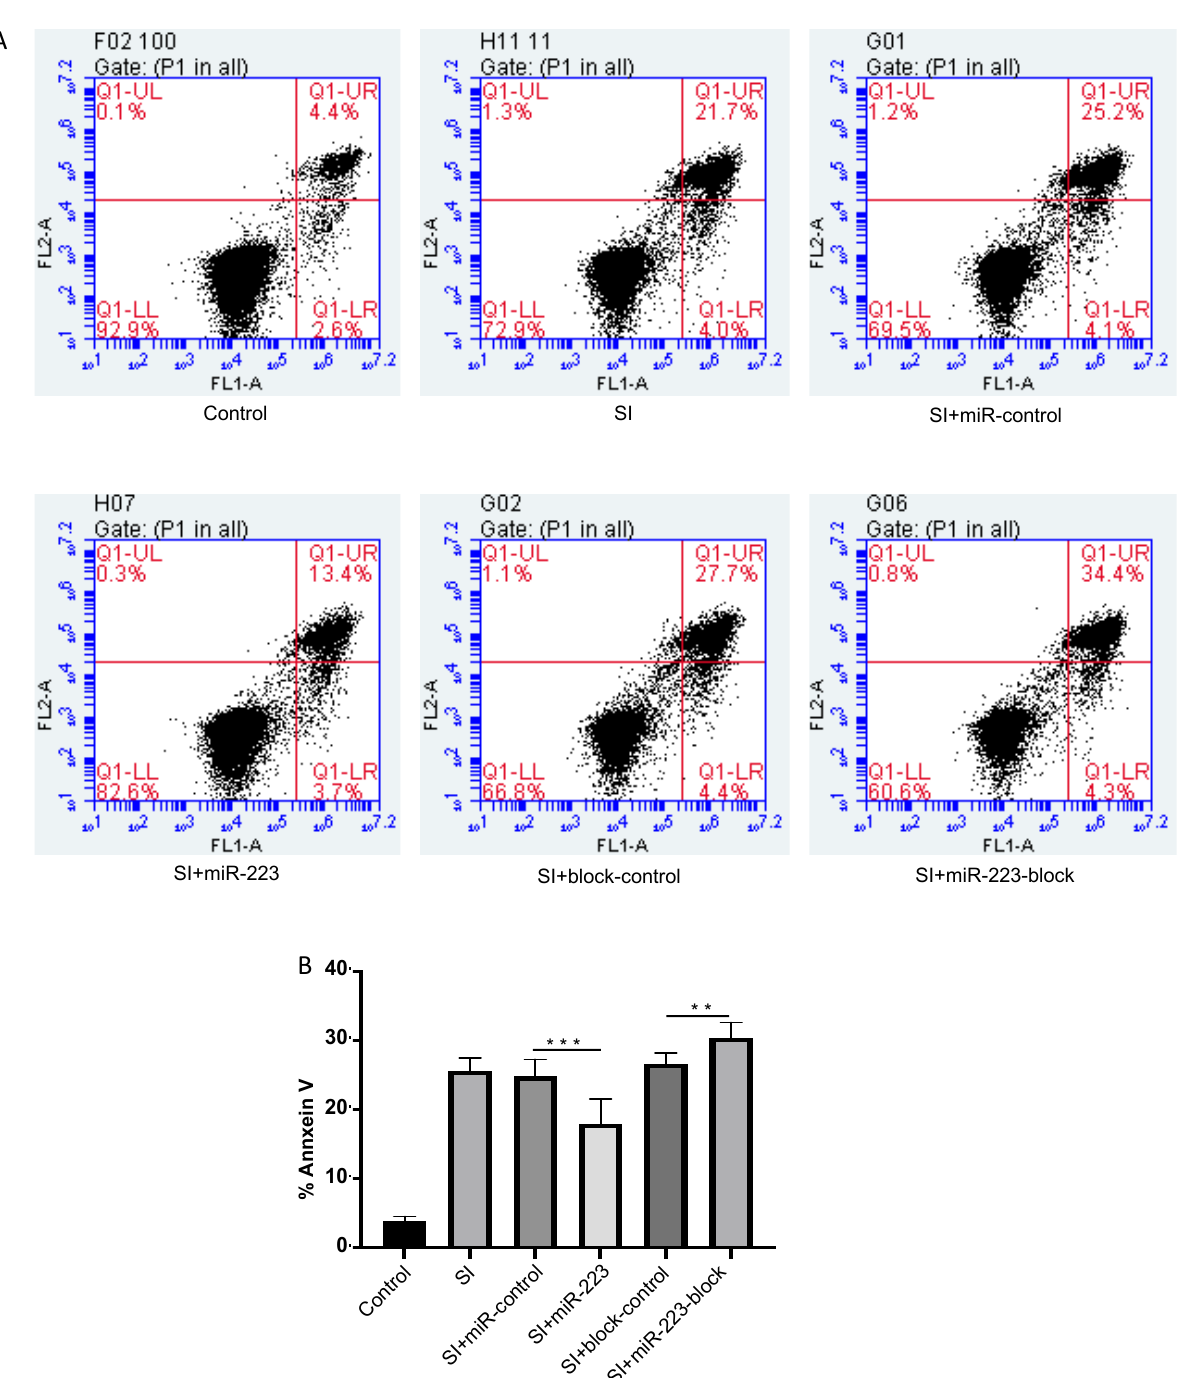
Figure 4. MiR-223 attenuates apoptosis in bEnd.3 cells after SI. BEnd.3 cells were detected by flow cytometry after immunostained with Annexin. ( A ) MiR-223 overexpressed bEnd.3 cells have lower fluo- rescence intensity compared to cells in miR-control group at 6 h post-injury. MiR-223-block transfected group has higher fluorescence than block-control group. ( B ) Bar graphs showing the quantification of the Annexin V intensity of cells in different groups. n = 8 per group; data are presented as the mean ± SD; ** p < 0.01, *** p < 0.001, miR-223 versus miR-control group, miR-223-block versus block-control group. miR-223: microRNA-223; h: hour; ZO-1: zonula occludens 1; SI: stretch